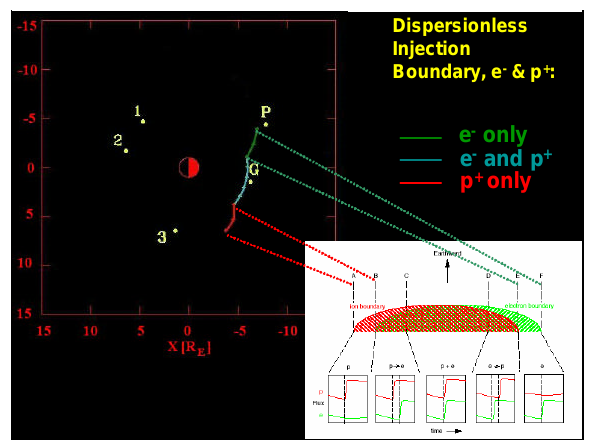
Fig. 4. A snapshot of the superimposed ion and electron dispersion- less injection boundary in the simulation is compared to a super- posed epoch analysis of particle injections, presented in Plate 2 of Birn et al. (1997a).